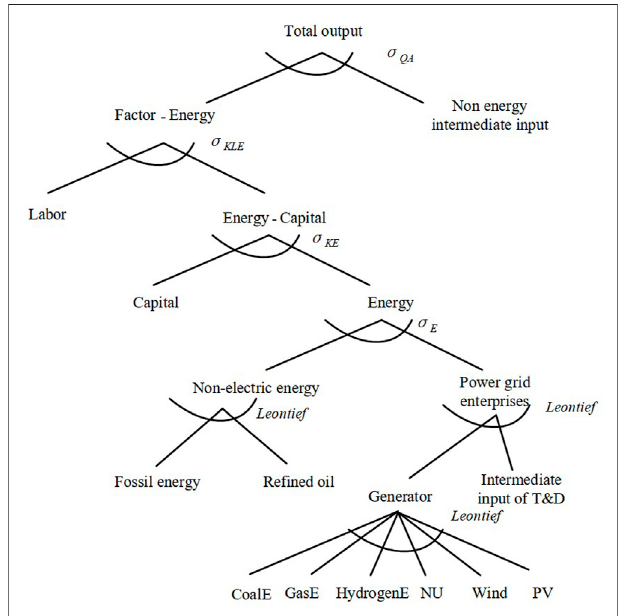
FIGURE 2 | Production function